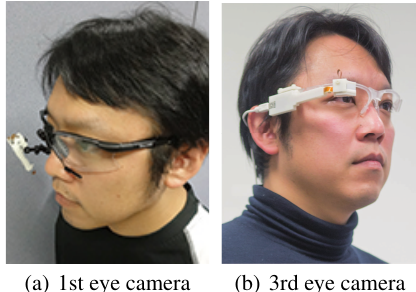
Figure 1 . Two types of eye cameras are used to estimate the object that is focused upon using the corneal surface image.